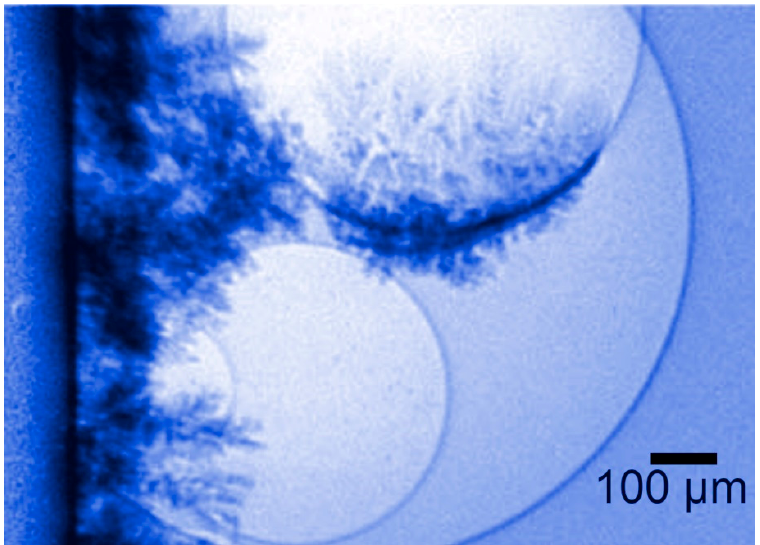
Figure 20. Coherence-based radiography proves a phenomenon that was previously difficult to believe: the growth of metal layers on the surface of gas bubbles during an electrodeposition process [27].